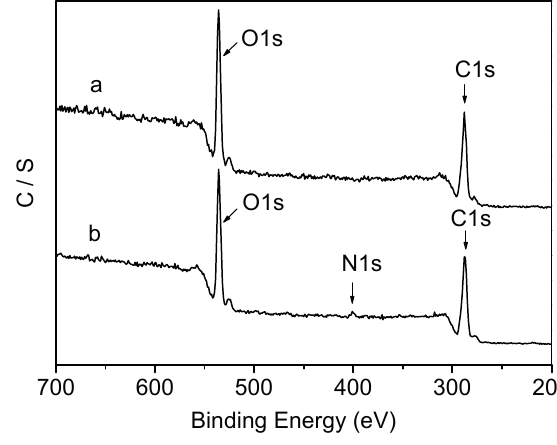
Figure 2. Fluorescence ( A ) emission spectra and ( B ) excitation spectra of (a) FITC-labeled collagen-PLA and (b) collagen.